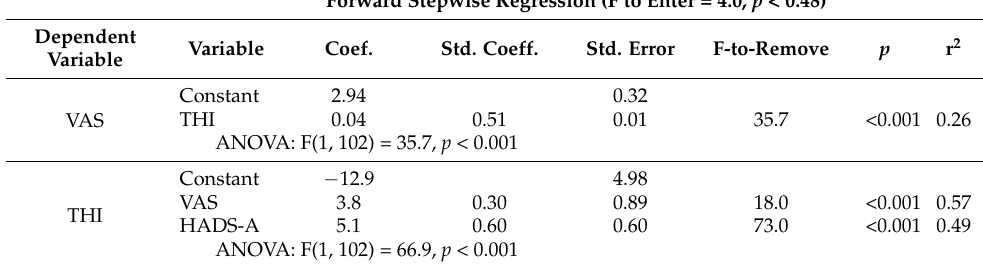
Table 5. Results of forward stepwise regression analysis to identify predictors of baseline VAS and THI scores.